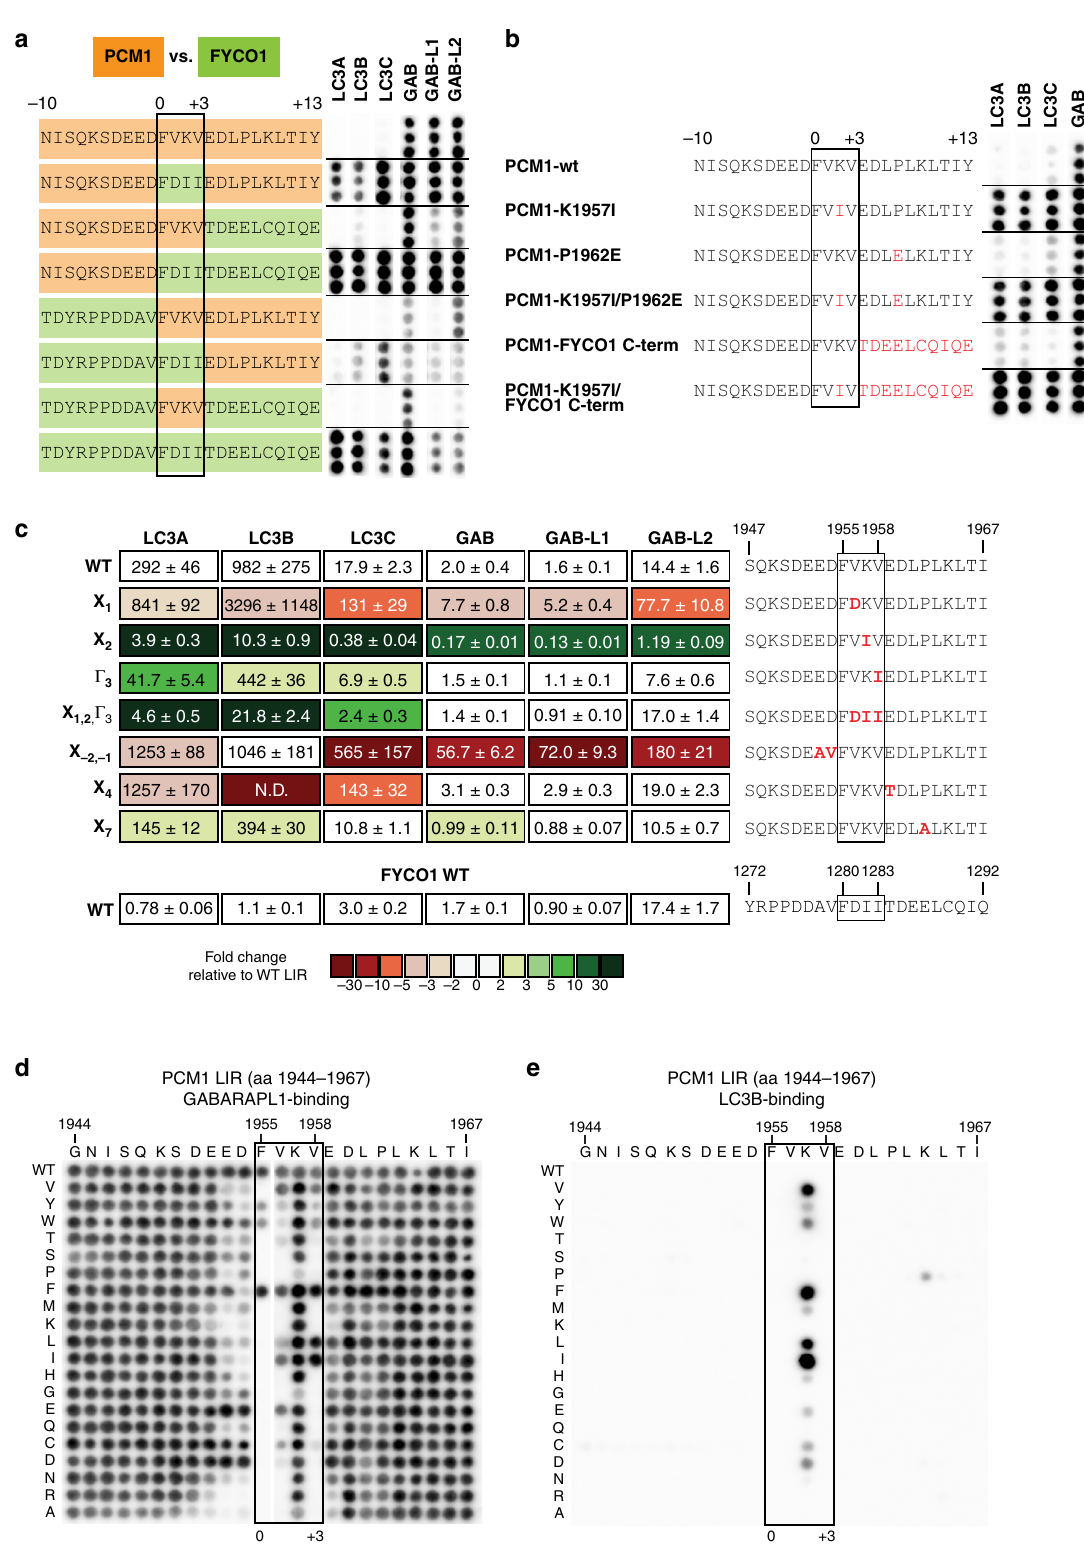
LC3 subfamily binding, indicating that LC3B binding was K1957 PCM1 , especially to aliphatic aa (isoleucine, leucine, and primarily regulated by K1957I PCM1 . valine) and phenylalanine, strongly increased GST-LC3B associa- tion (Fig. 4e). Although GST-GABARAP 26 and GST-GABARAP- A mutational peptide array scan (Fig. 4d, e) further L1 (Fig. 4d) binding was slightly enhanced by mutations of corroborated that the lysine residue in position X 2 alone is suf fi cient in inhibiting LC3B binding. Single mutation of position X 2 , overall, GABARAP proteins seem to be able to NATURE COMMUNICATIONS| (2019) 10:2055